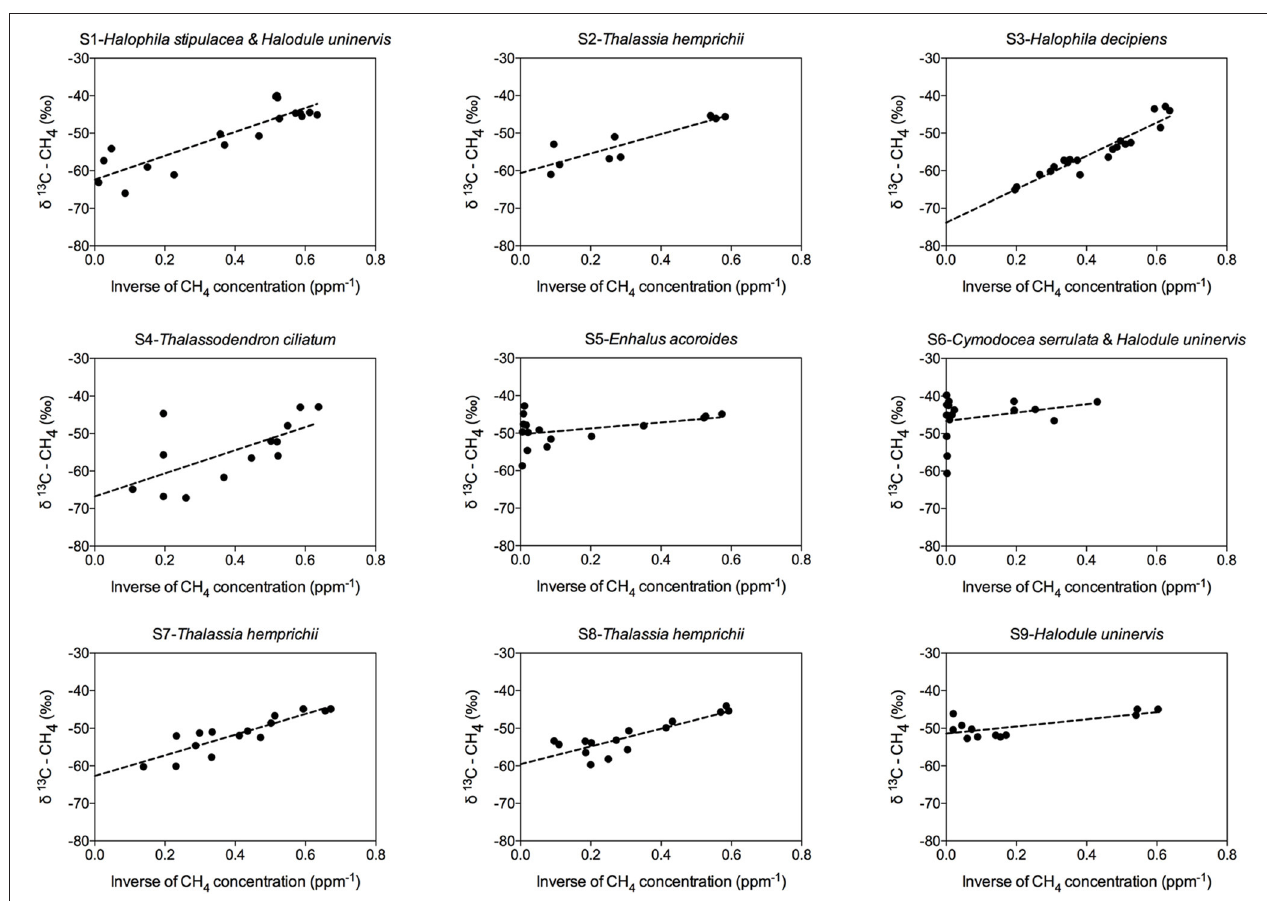
FIGURE 3 | Keeling plots for each seagrass station, showing the linear regression fitting (dashed line) between the inverse of the CH 4 concentration and the δ 13 C–CH 4 , used to calculate the isotopic signature of the source CH 4 as the intercept of